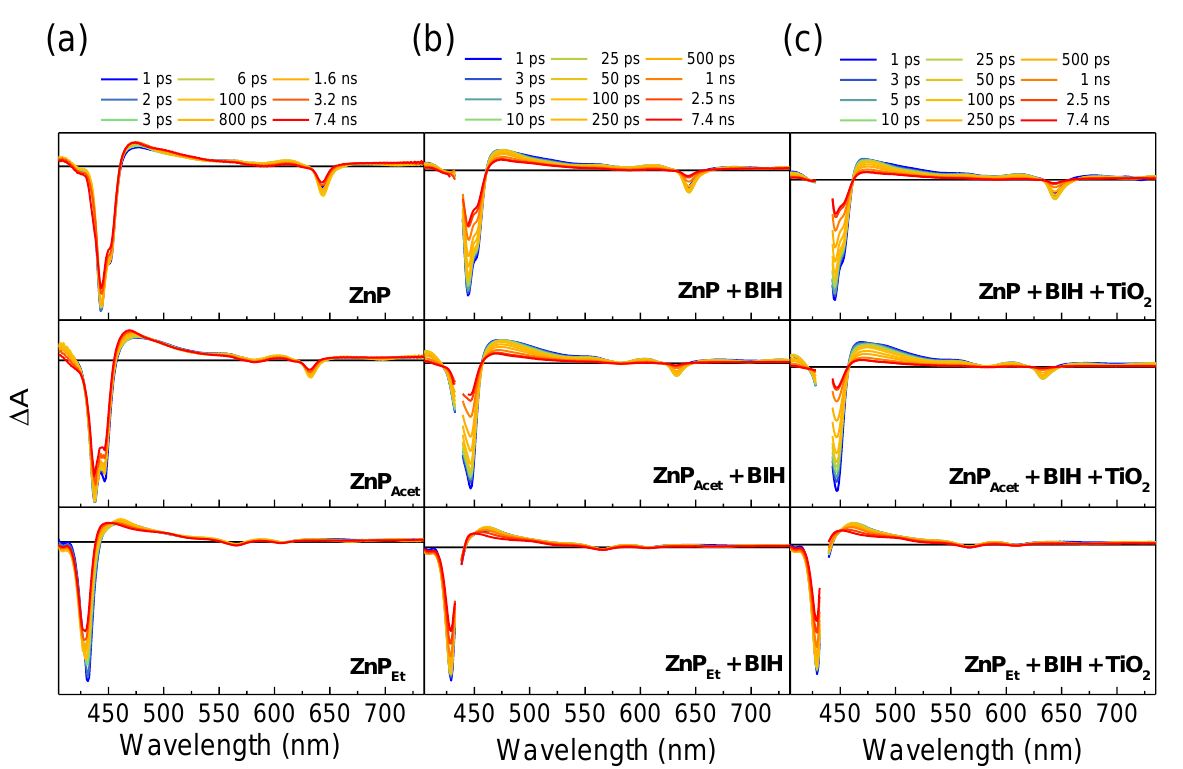
particle. In contrast, the TA spectra of ZnP Et measured with the addition of BIH and TiO 2 reveal the same behaviors as those with only BIH added.